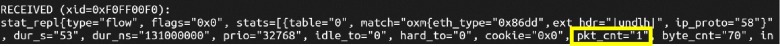
Snapshot of the switch showing that Flow-Entry-2 matches one packet.